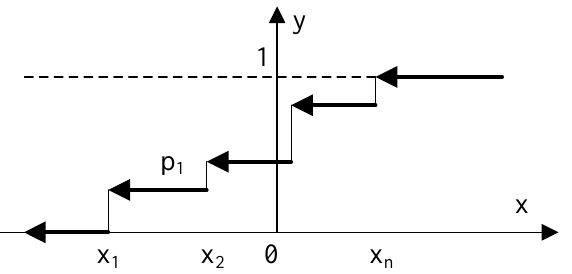
Figure 8. Piecewise continuous distribution function y = ϕ ( u ), where x = u = ( ω − ξ )/( ξ · σ ) based on the